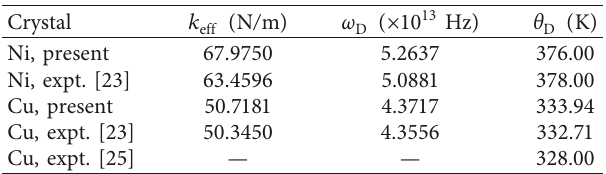
Table 2: The values of local force constant k ω D , and temperature θ D of Ni and Cu calculated using the present theory compared to experiment [23, 25].